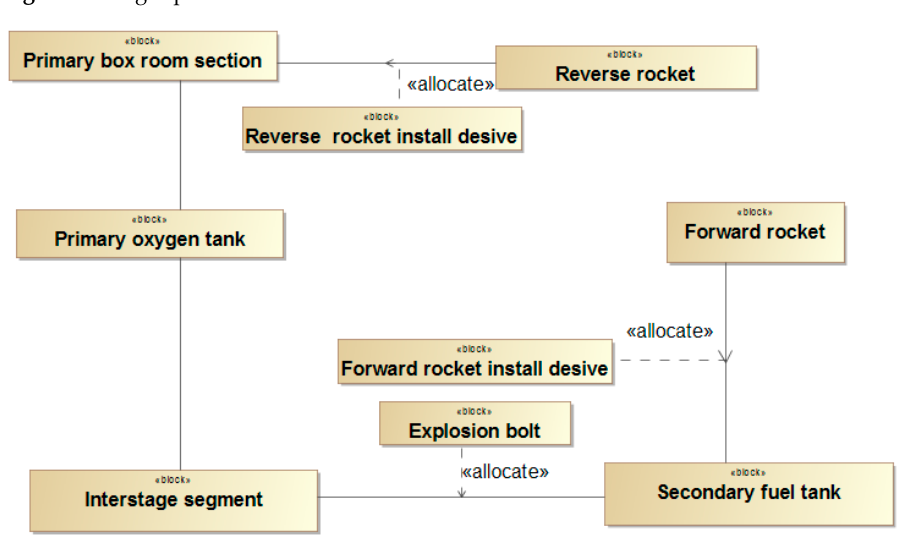
Figure 17. System layout. Figure 17. System